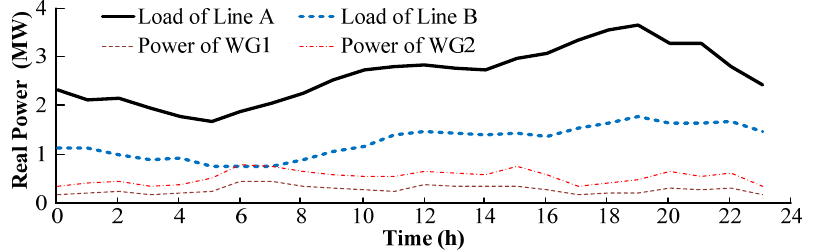
Figure 7. Load of ADN and power of wind